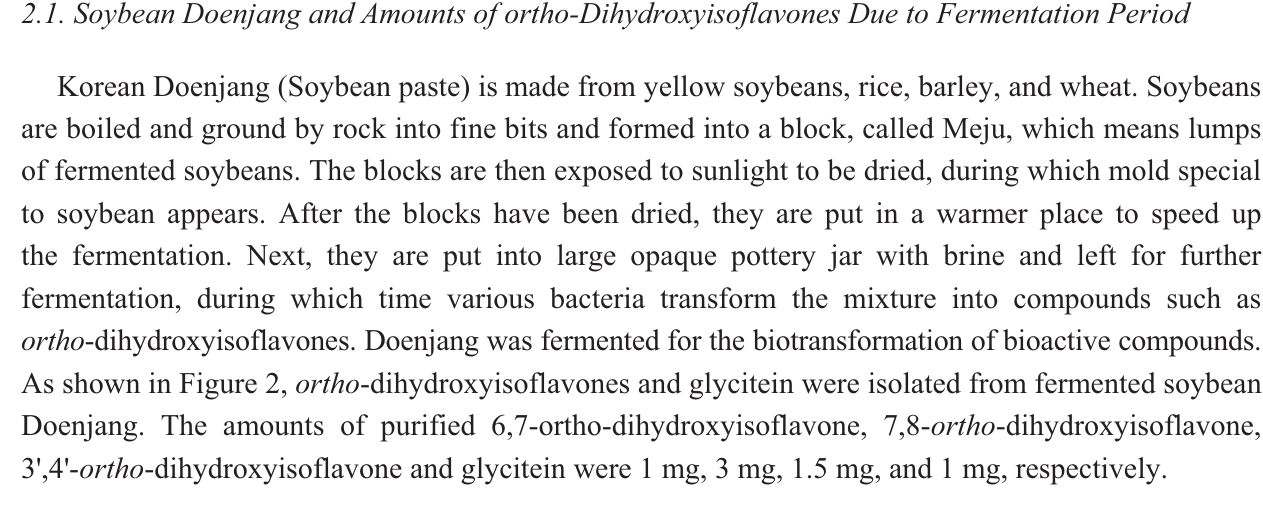
Figure 2. Amounts of isolated compounds from fermented soybean